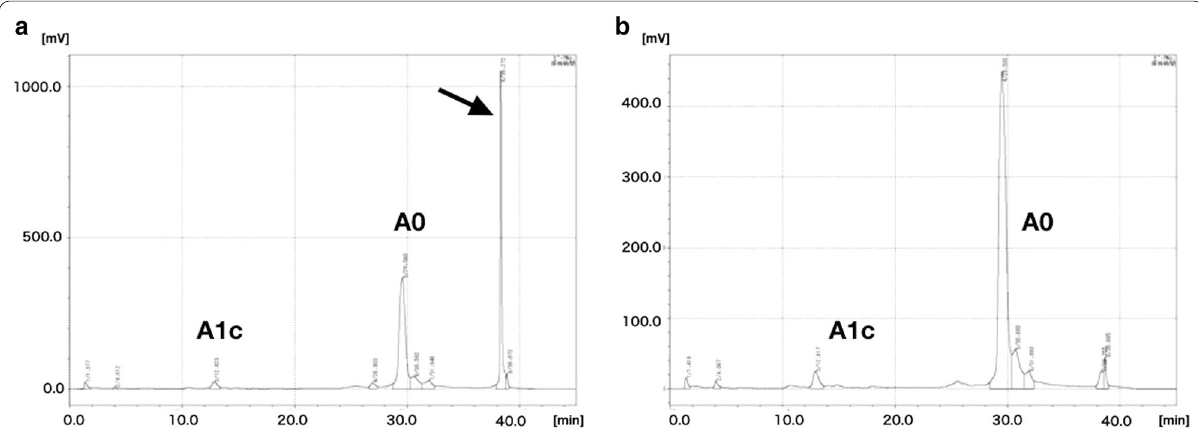
Fig. 6 Elution curve obtained by high-performance liquid chromatography analysis of the patient ( a ) and a healthy control ( b ). An elution peak corresponding to HbS is indicated by the arrow ( a